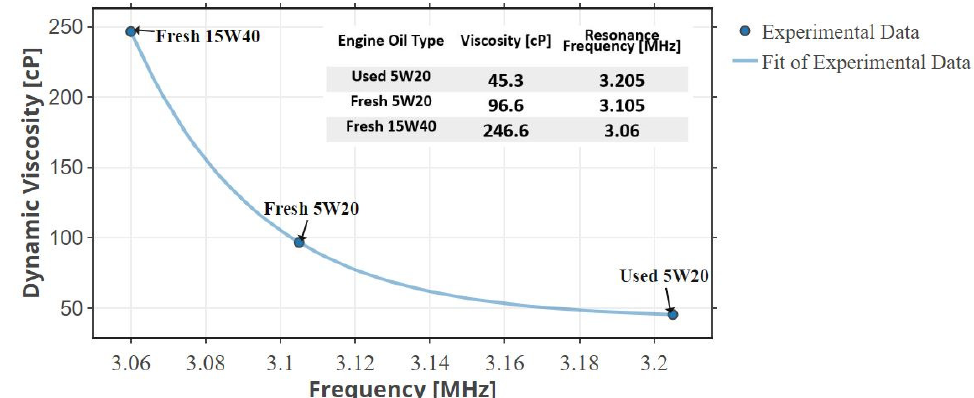
Figure 17. Resonance frequency comparison of different oil types (different viscosities) under the same conditions.